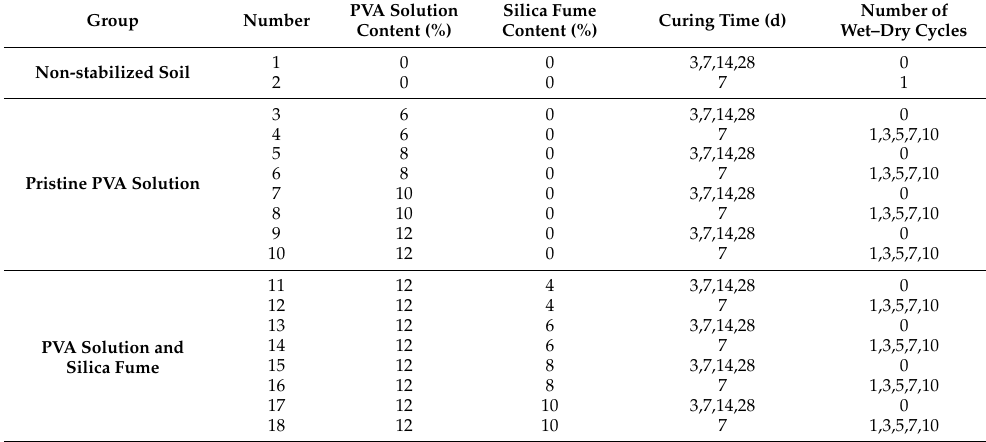
Table 4. The stabilizer content, curing time and number of wet–dry cycles adopted for different